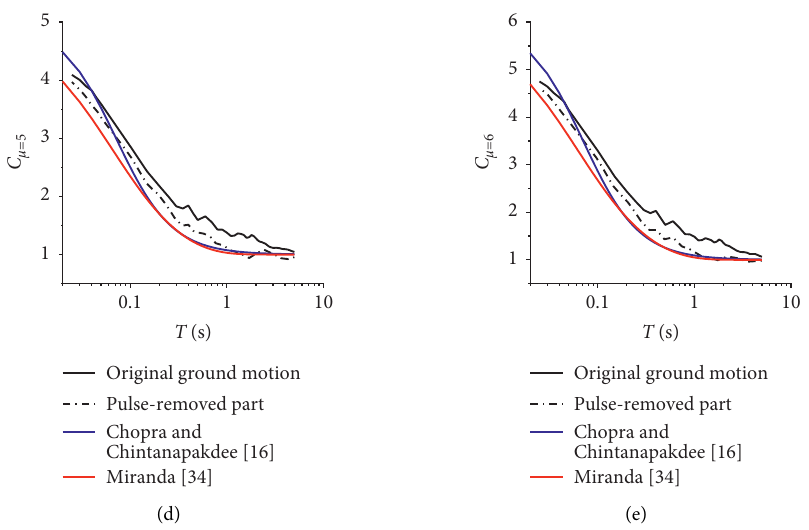
Figure 4: Comparison of the mean of the inelastic displacement ratios for the 65 original ground motions and the corresponding pulse- removed parts and the regression results of two previous studies for (a) µ � 2, (b) µ � 3, (c) µ � 4, (d) µ � 5, and (e) µ � 6.